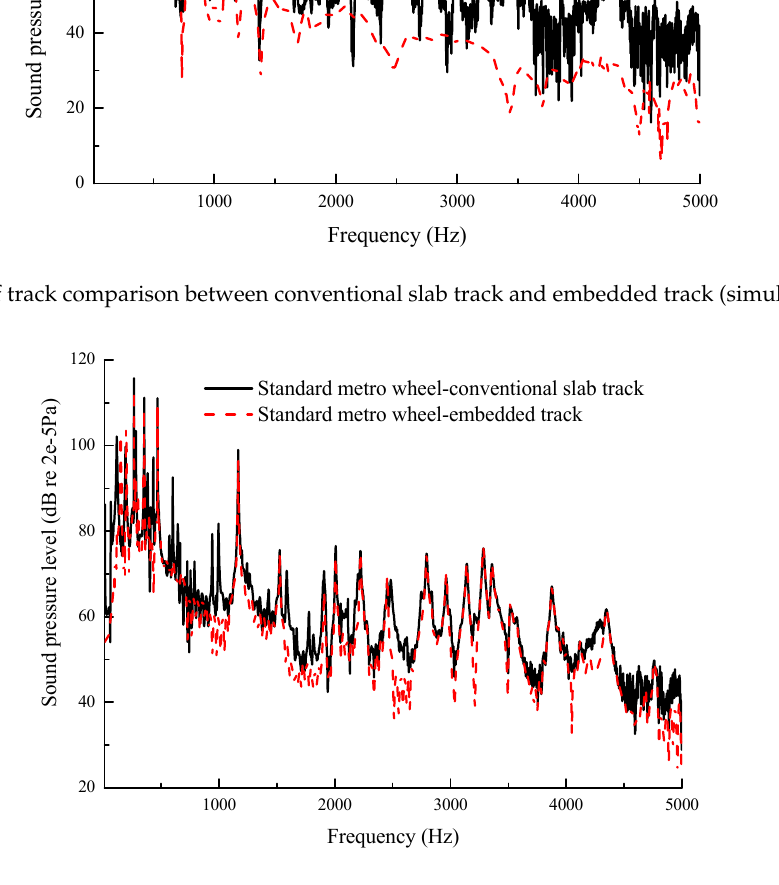
Figure 17. SPL compare between standard metro wheel and embedded track (simulation results).